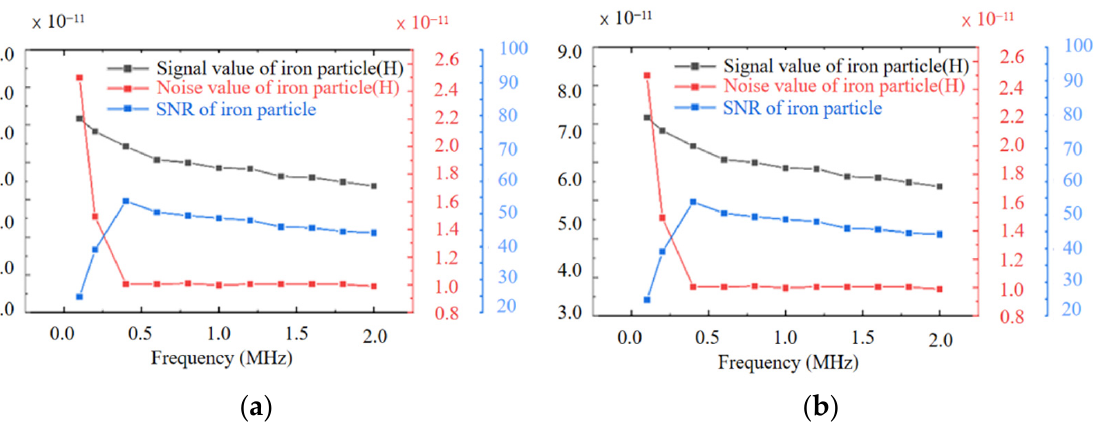
Figure 9. Detection signal value, noise value, and SNR of metal particles under different excitation frequencies: ( a ) waveform plots for detecting 50–60 μ m iron particles, ( b ) waveform plots for detecting 100–110 μ m copper particles.